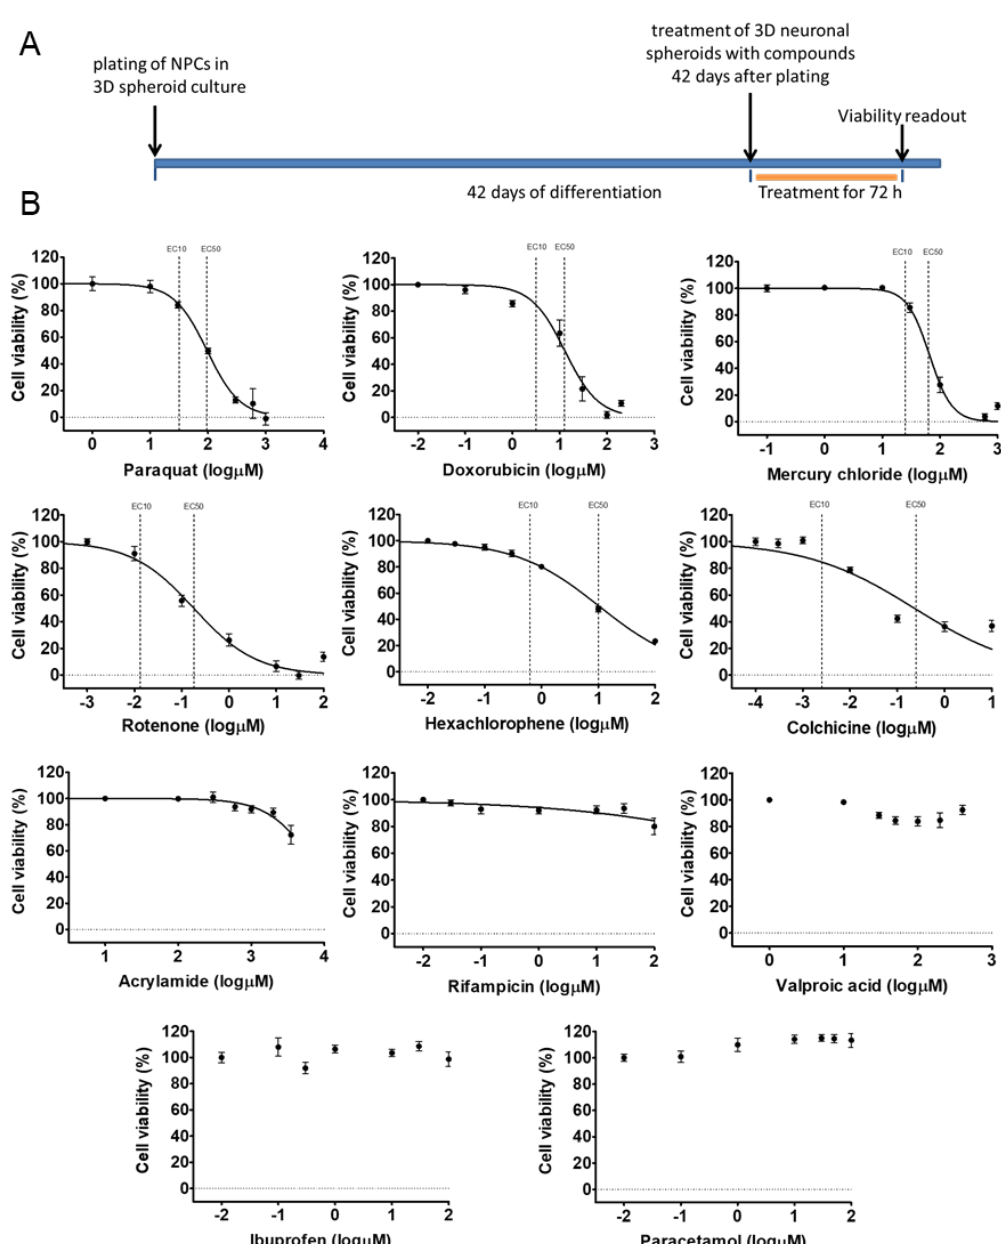
Figure 7. Cell viability measurement on D42 3D neurospheres after 72 h exposure with toxicants. ( A ) exposure scheme at D42 stage. ( B ) Concentration-response curves of compounds, tested in 7 different concentrations (see concentrations listed in Table S3), representing the cell viability (%) of treated D42 3D neurospheres ( n = 3). Concentration values are presented in log µM ± SEM. EC10 and EC50 values are presented on graphs where applicable.